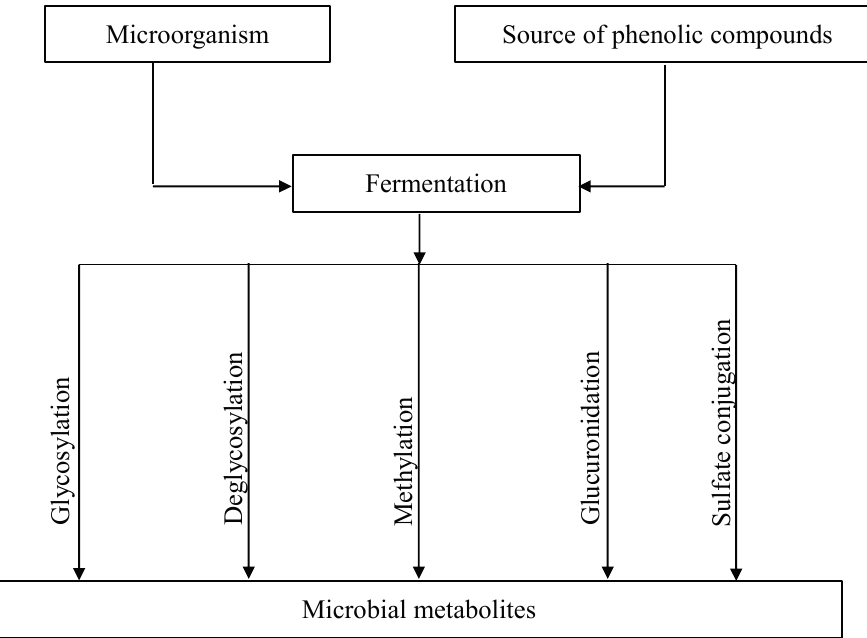
Figure 2. A schematic diagram of microbial conversion of phenolic